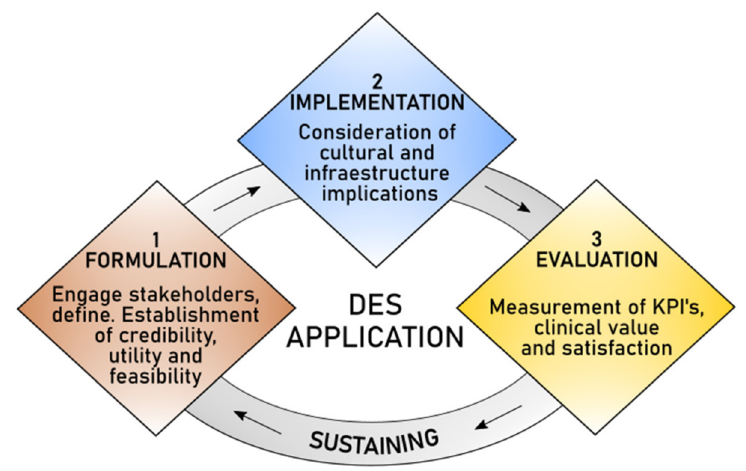
Figure 4. Holistic perspective for DES applications in